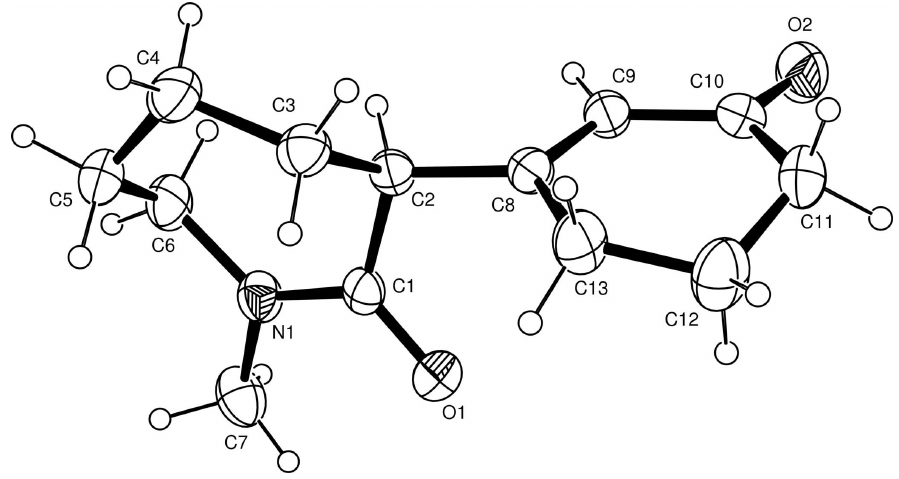
Figure 1 The molecular structure of (I), with displacement ellipsoids for the non-hydrogen atoms drawn at the 50% probability